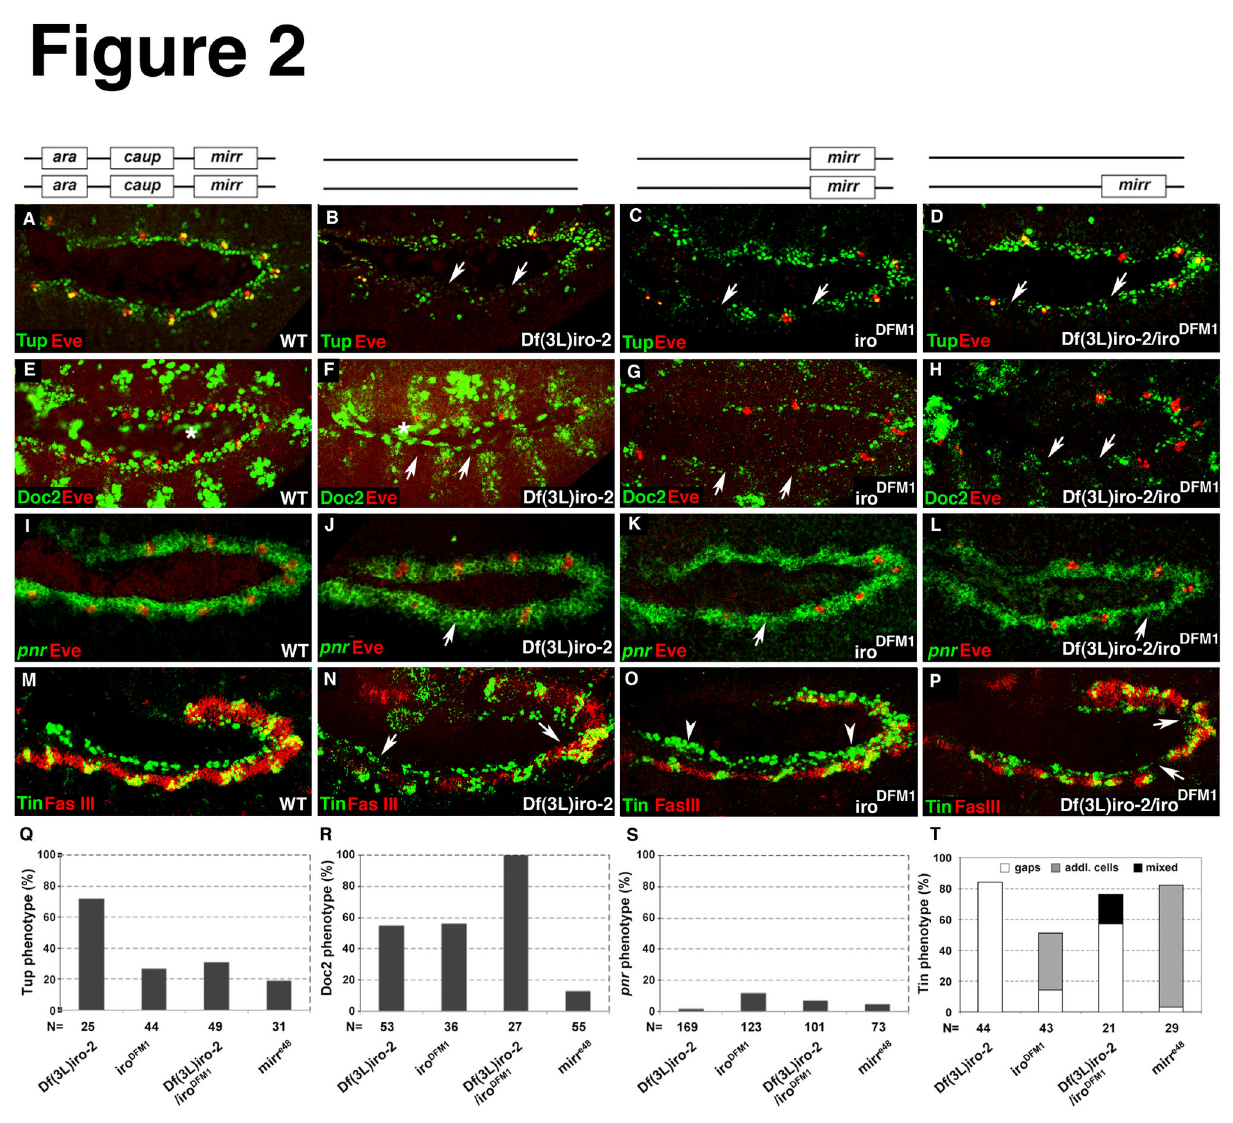
Figure 2. Iro-C is required for the normal expression of early cardiac transcription factors. Phenotypes were analyzed in different Iro-C mutants. The genetic background is depicted in the drawing above each column. The boxes illustrate the presence of the indicated factor. (A-D). Embryos mutant for Iro-C exhibit a reduction of Tup-expressing cells (arrows). (E-H) Doc 2- expressing cells are strongly reduced along the dorsal edge of the mesoderm (arrows). Asterisks in E and F indicate Doc 2 expression in the amnioserosa. (I-L) pnr mRNA expression is unaffected in 85-95% of the different Iro-C mutants. Arrows point to missing Eve cell clusters. (M-P) Tin expression is affected in the different Iro-C mutants. Images are merged optical sections of double immunostainings for Tin and Fasciclin III (FasIII) in which Tin-positive cells in the visceral mesoderm labeled by FasIII appear yellow. (N) Df (3L) iro-2 embryos are characterized by a reduction of Tin-expressing cells (arrows) and reduced FasIII expression. (O) Embryos mutant for ara/caup only (iro DFM1 ) are characterized by an increase in Tin-positive cells in the cardiac region (arrowheads). (P) The predominant phenotype in Df (3L) iro-2/ iro DFM1 heterozygotes is a slight reduction of Tin and FasIII expression (arrows). (Q-T) Quantification of the phenotypes observed. The bar graphs depict the percentage of embryos that exhibited a phenotype. The bar graphs in Q-S depict the percentage of embryos that had reduced expression of the indicated markers. All images show lateral views of stage10/11 embryos; anterior is to the left.